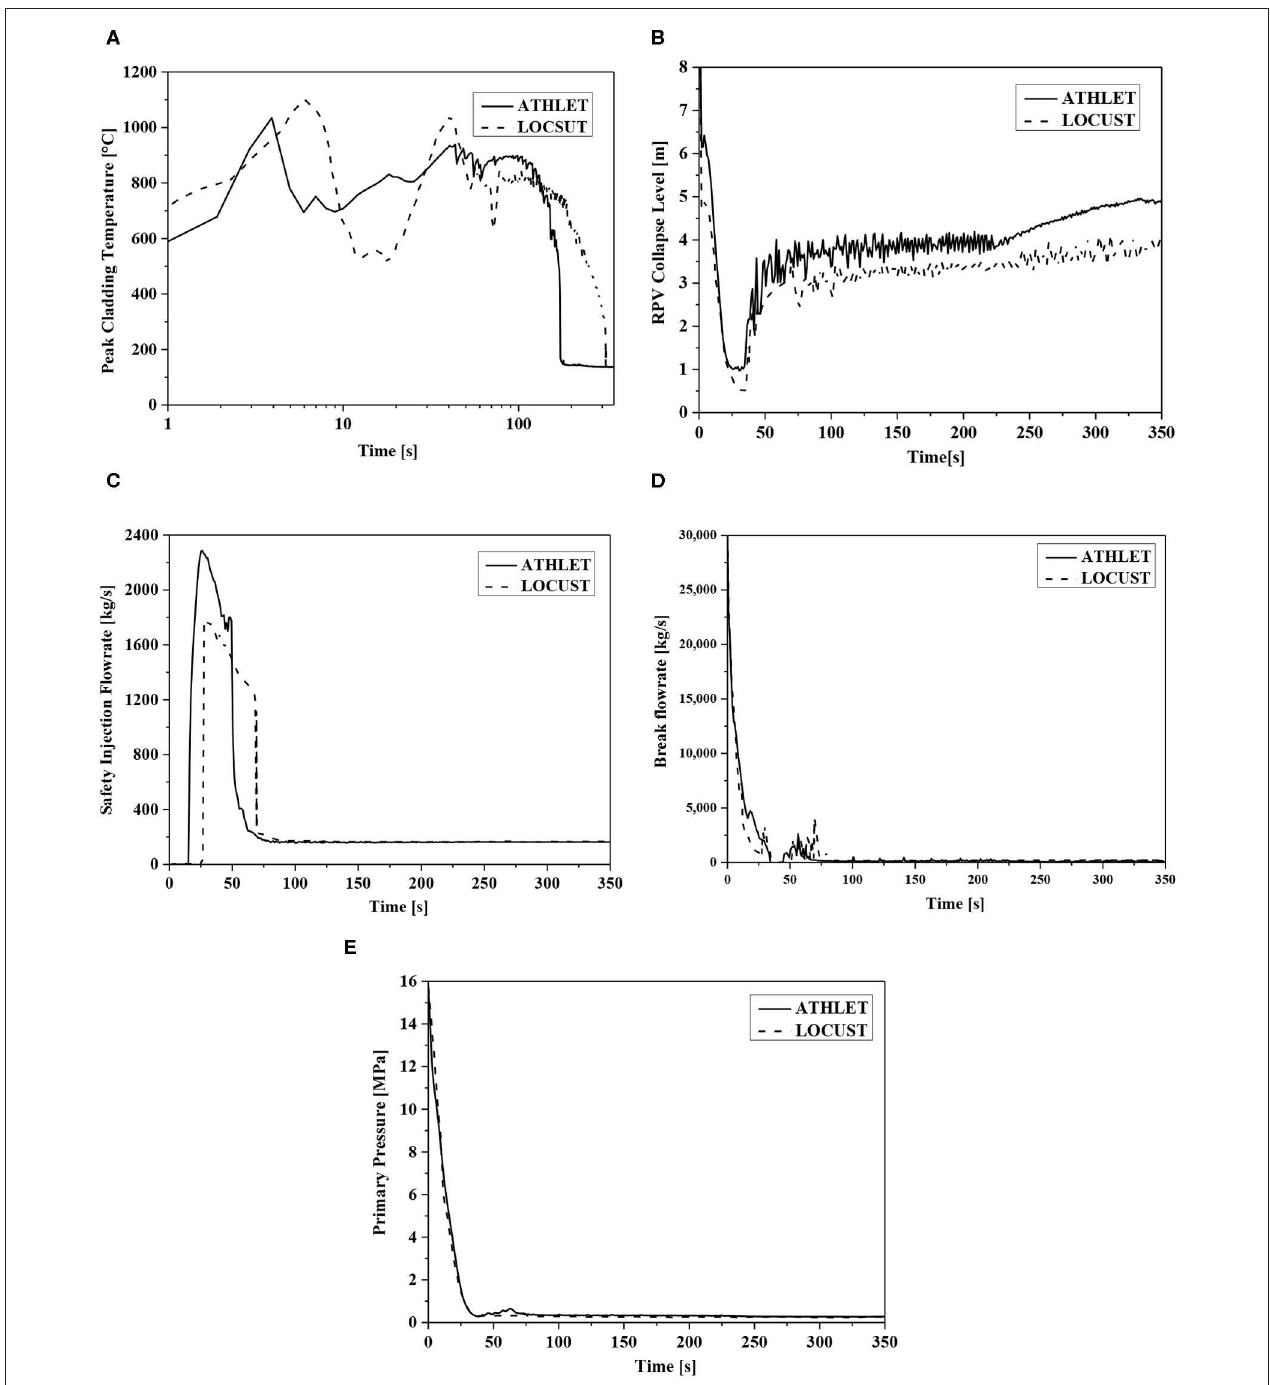
FIGURE 5 | Simulation results of LB-LOCA for HPR1000. (A) Peak cladding temperature (PCT) change. (B) The change of RPV collapse level. (C) The change of safety injection flowrate. (D) The change of break flowrate. (E) The change of primary pressure.